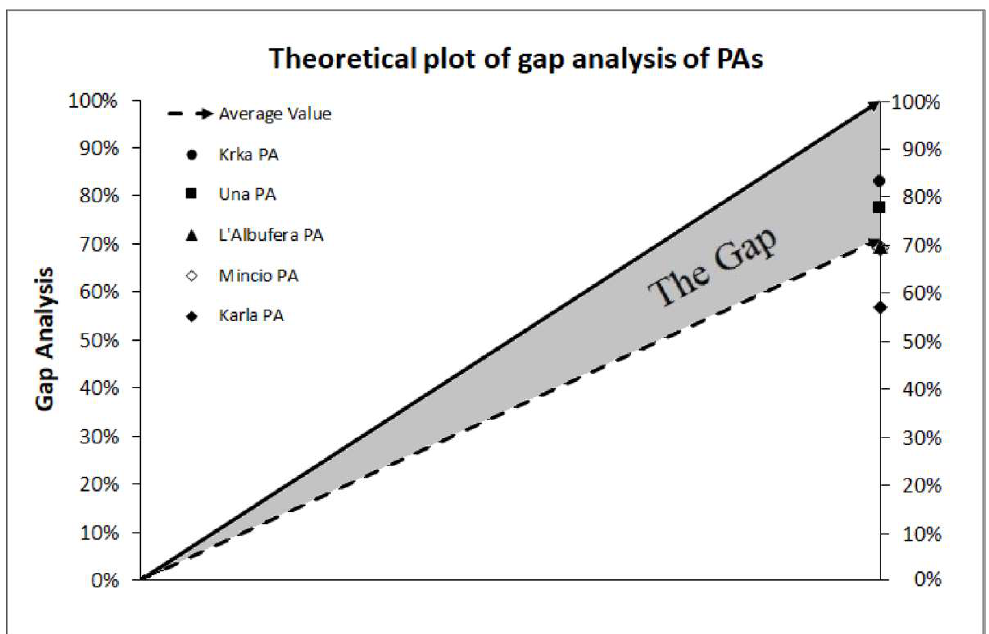
Figure 5. Theoretical plot of average gap for the three fields, for five PAs and their individual grading.